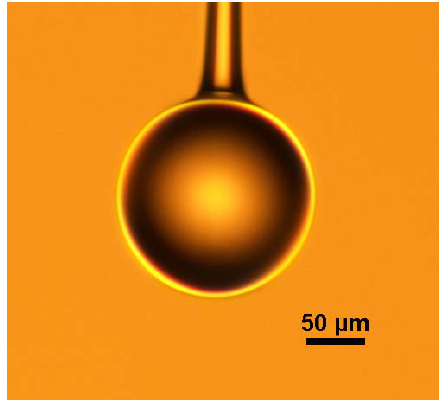
Figure 2. Microscope image of silica microsphere made with CO 2 laser.